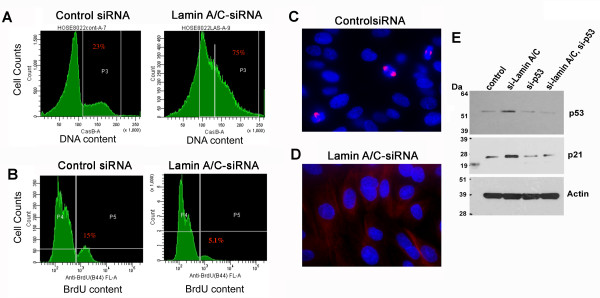
Lamin A/C suppression in primary ovarian epithelial cells results in growth retardation. Primary HOSE cells were transfected with control or shRNA to suppress lamin A/C expression. The cells were analyzed for DNA content and bromodeoxyuridine (BrdU) incorporation simultaneously by flow cytometry. (A) Primary HOSE cells were analyzed by flow cytometry for DNA content following treatment with control or lamin A/C shRNA for three days. Lamin A/C-suppressed cells have > 2n DNA in 75% of cells, compared to 23% of control cells. (B) The same cell populations were incubated with BrdU for one hour in culture, and then fixed and stained with FITC-anti-BrdU prior to flow cytometry to determine BrdU incorporation as an indicator of proliferation. (C) The control cells show a high percentage of mitotic nuclei as shown by immunofluorescence microscopy of beta-tubulin staining of the mitotic spindles. (D) In comparison, beta-tubulin-immunostained mitotic spindles are rare in lamin A/C-suppressed cells. (E) The HOSE cells were treated with siRNA-p53 and/or siRNA-lamin A/C for three days and then analyzed for p53 and p21 by Western blot.